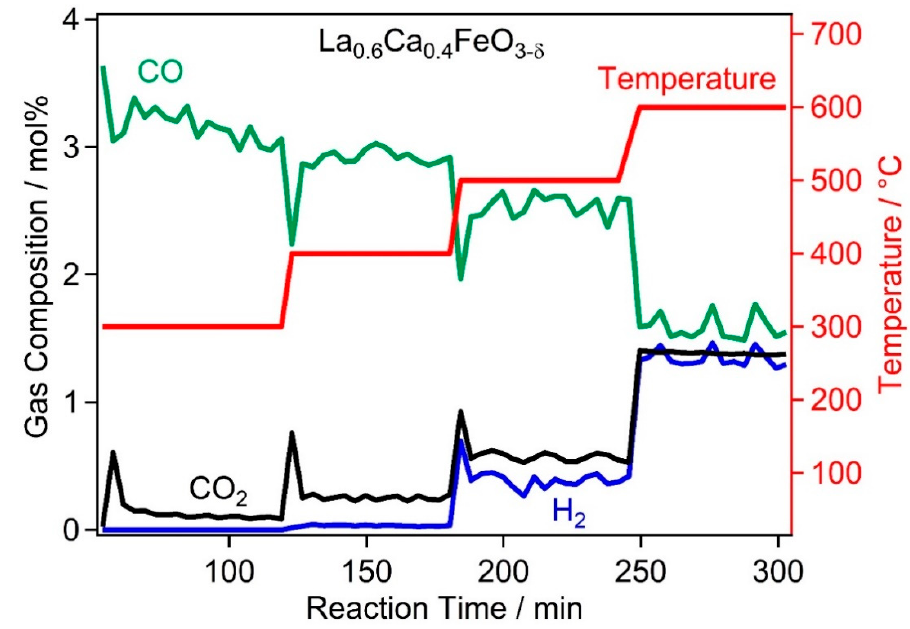
Figure 2. WGS reaction on La 0.6 Ca 0.4 FeO 3- δ . The reaction temperature was gradually increased from 300 to 600 °C. Signals for CO (orange), CO 2 (black) and H 2 (blue) are displayed. During the initial temperature steps, short spikes in the CO 2 production are visible, originating from lattice oxygen reacting with CO.